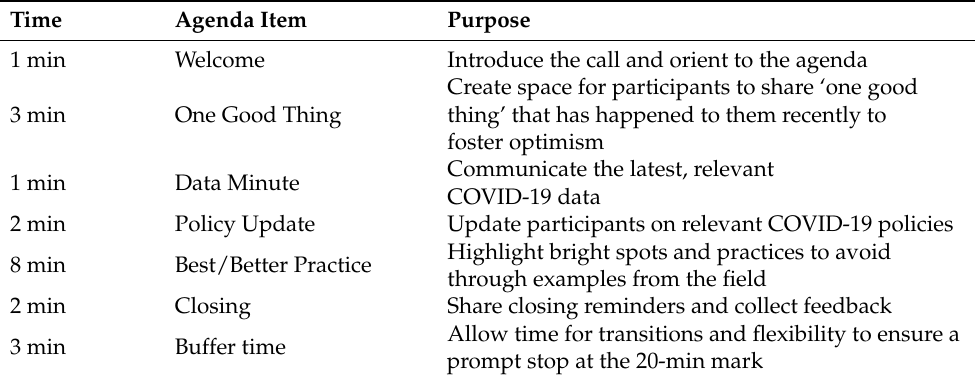
Table 1. Standard agenda for RRN